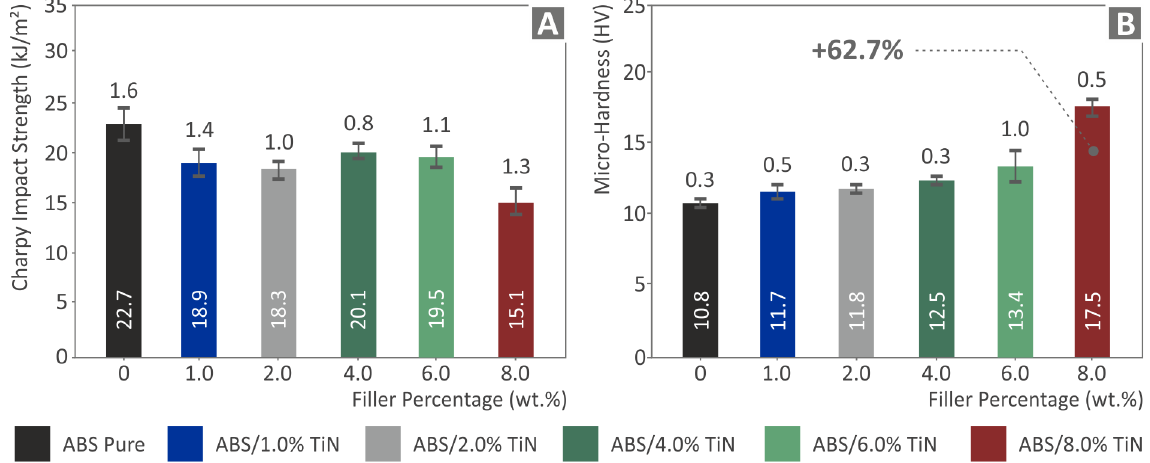
Figure 10. Results (average values and deviation) from ( A ) Impact strength and ( B ) Vickers micro- hardness tests of the six 3D-printed specimens.